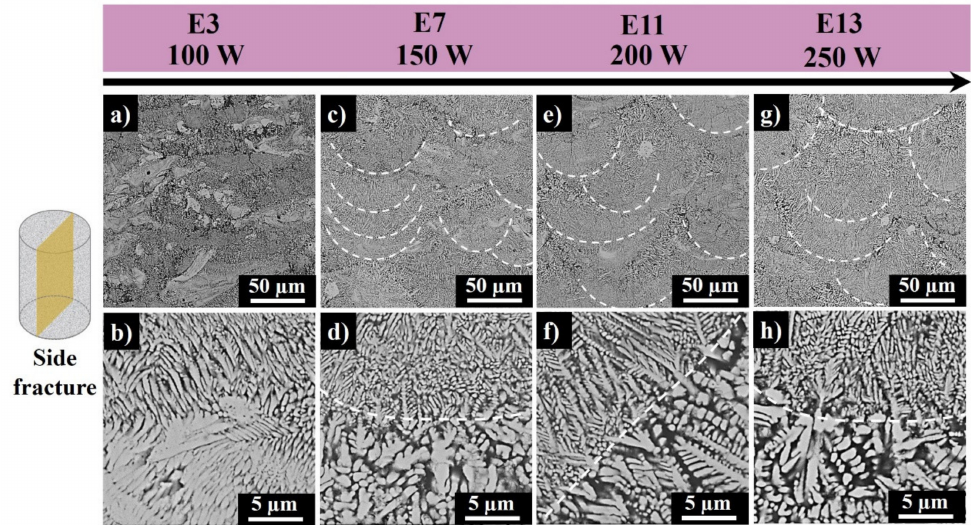
Figure 12. Side surface SEM images of sample E3 ( a , b ), E7 ( c , d ), E11 ( e , f ), and E13 ( g , h ) produced at 100 W, 150 W, 200 W, and 250 W laser powers, respectively, and at 700 mm · s − 1 scanning speed (white dashed semi-ovals in panels ( c – g ) represent melt pools, and the white dashes in panels ( d – h ) show the morphology transition zone from melt pool core to